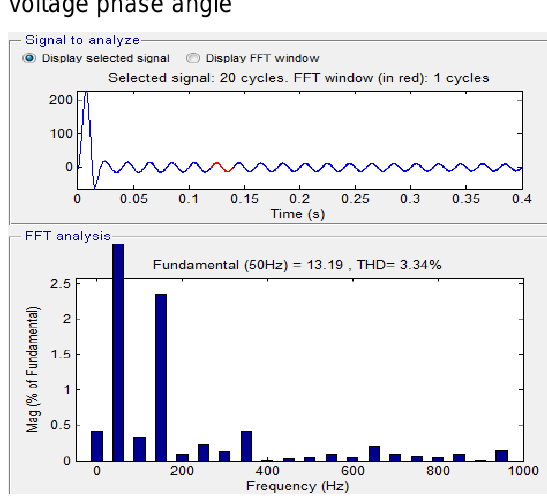
Figure 13. Load current and voltage phase angle